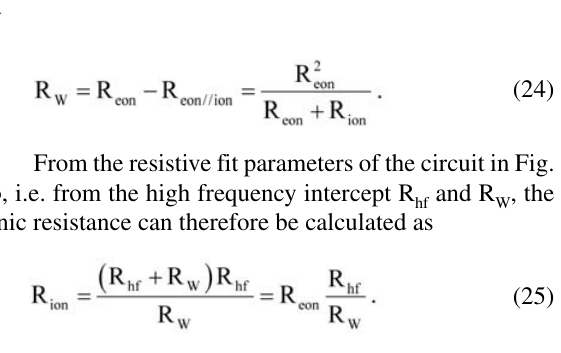
Fig. 7. Impedance spectrum measured at 800 °C between two interdigitating Pt electrodes on a Sr(Ti insulating MgO substrate (sketch); the photograph shows a top view of the electrode geometry. The spectrum can be fitted to the circuit in Fig. 6c with a rather ideal finite Warburg element at low